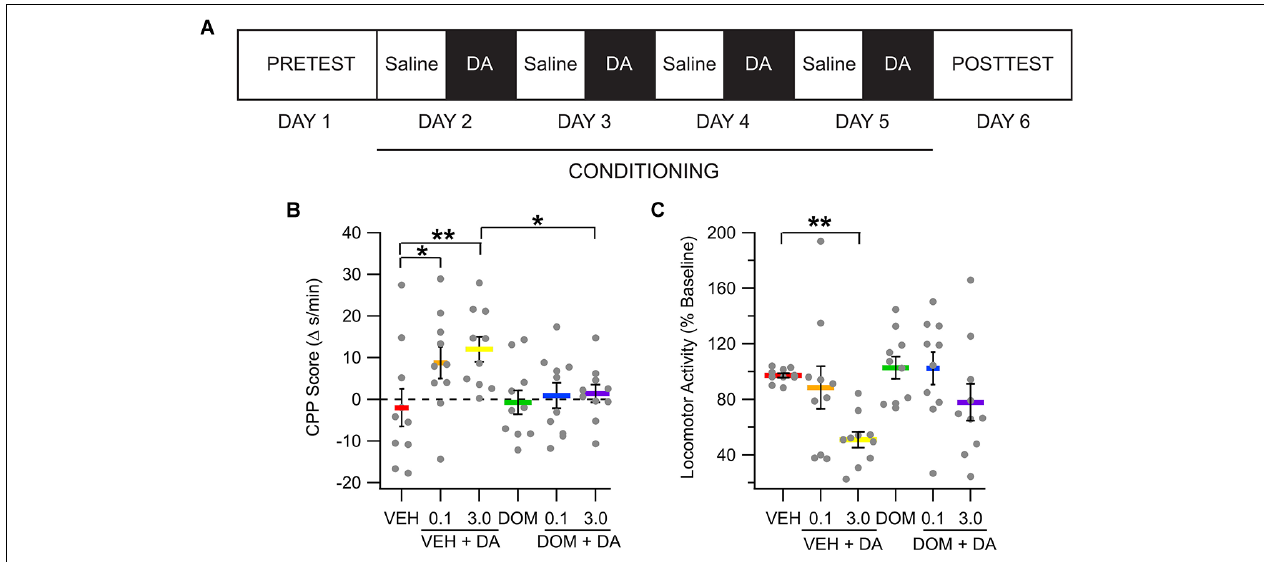
FIGURE 4 | Intravenous DA produces conditioned place preference. (A) Diagram showing the timing of different phases of the place conditioning experiments. (B) The amount of time spent on the CS + floor increased in the IV DA (0.1 mg/kg) and IV DA (3.0 mg/kg) groups. This effect was attenuated by pretreatment with domperidone (DOM; 1 mg/kg, IV). (C) The IV DA (3.0 mg/kg) group had significantly reduced locomotor activity during CS + sessions as compared with the vehicle group. * indicates p < 0.05, ** indicates p < 0.01.